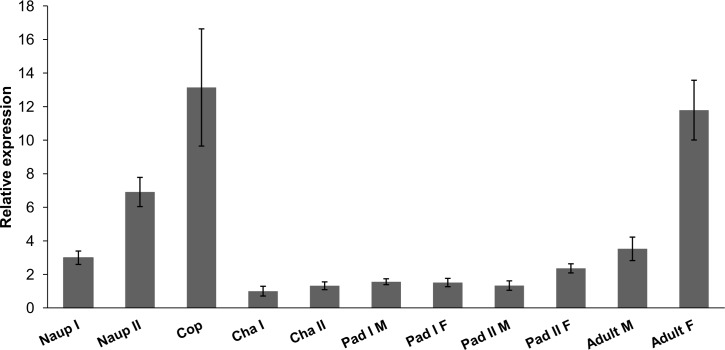
Expression analysis of the LsLpR in various developmental stages of the salmon louse.Expression levels of LsLpR in chalimus I was set as 1. Error bars represent the standard deviation (n = 5 samples for each stage). Abbreviations: Naup I, Nauplii I: Naup II, Nauplii II: Cop, free-living copepodids: Cha I, Chalimus I: Cha II, Chalimus II: Pad I M, Preadult I male: Pad I F, Preadult I female: Pad II M, preadult II male: Pad II F, Preadult II female.